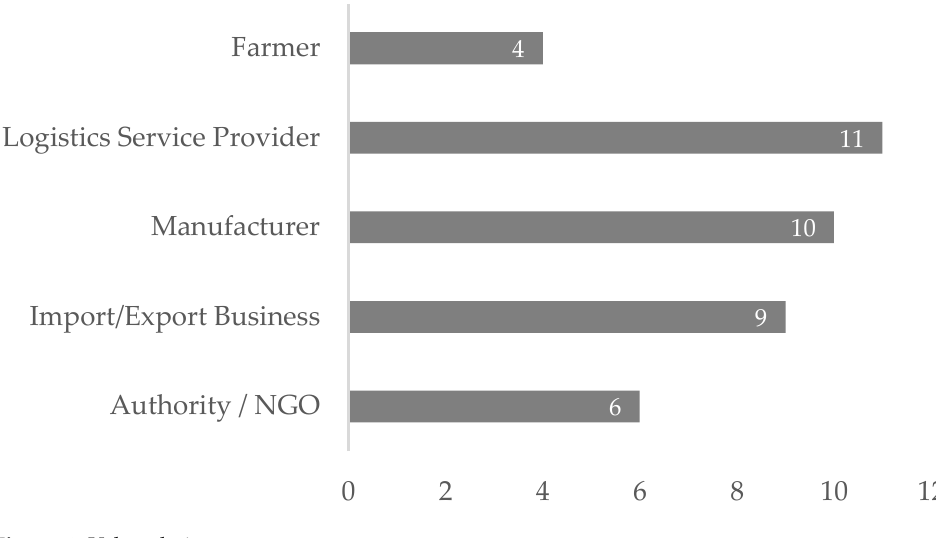
Figure 5. Organisation size by employees and annual revenue in USD. According to the European Union’s definition, 36 of the participating organisations were small- and medium-sized enterprises [32]. While 5 organisations were micro com- panies, 10 were small companies and 21 were medium-sized companies. 3.2.2. Cluster Analysis Clustering is an unsupervised technique for grouping similar objects, whereby the structure of the data determines the best groups. Unsupervised means that the application of the chosen algorithm is carried out by the system without external influence. Thus, the solution path is not necessarily transparent to the applying scientist. The groups therefore resulted from the chosen algorithm. All observations were evaluated based on their ‘dis- tance‘ from one another and grouped into clusters. In this case, the proximity or distance